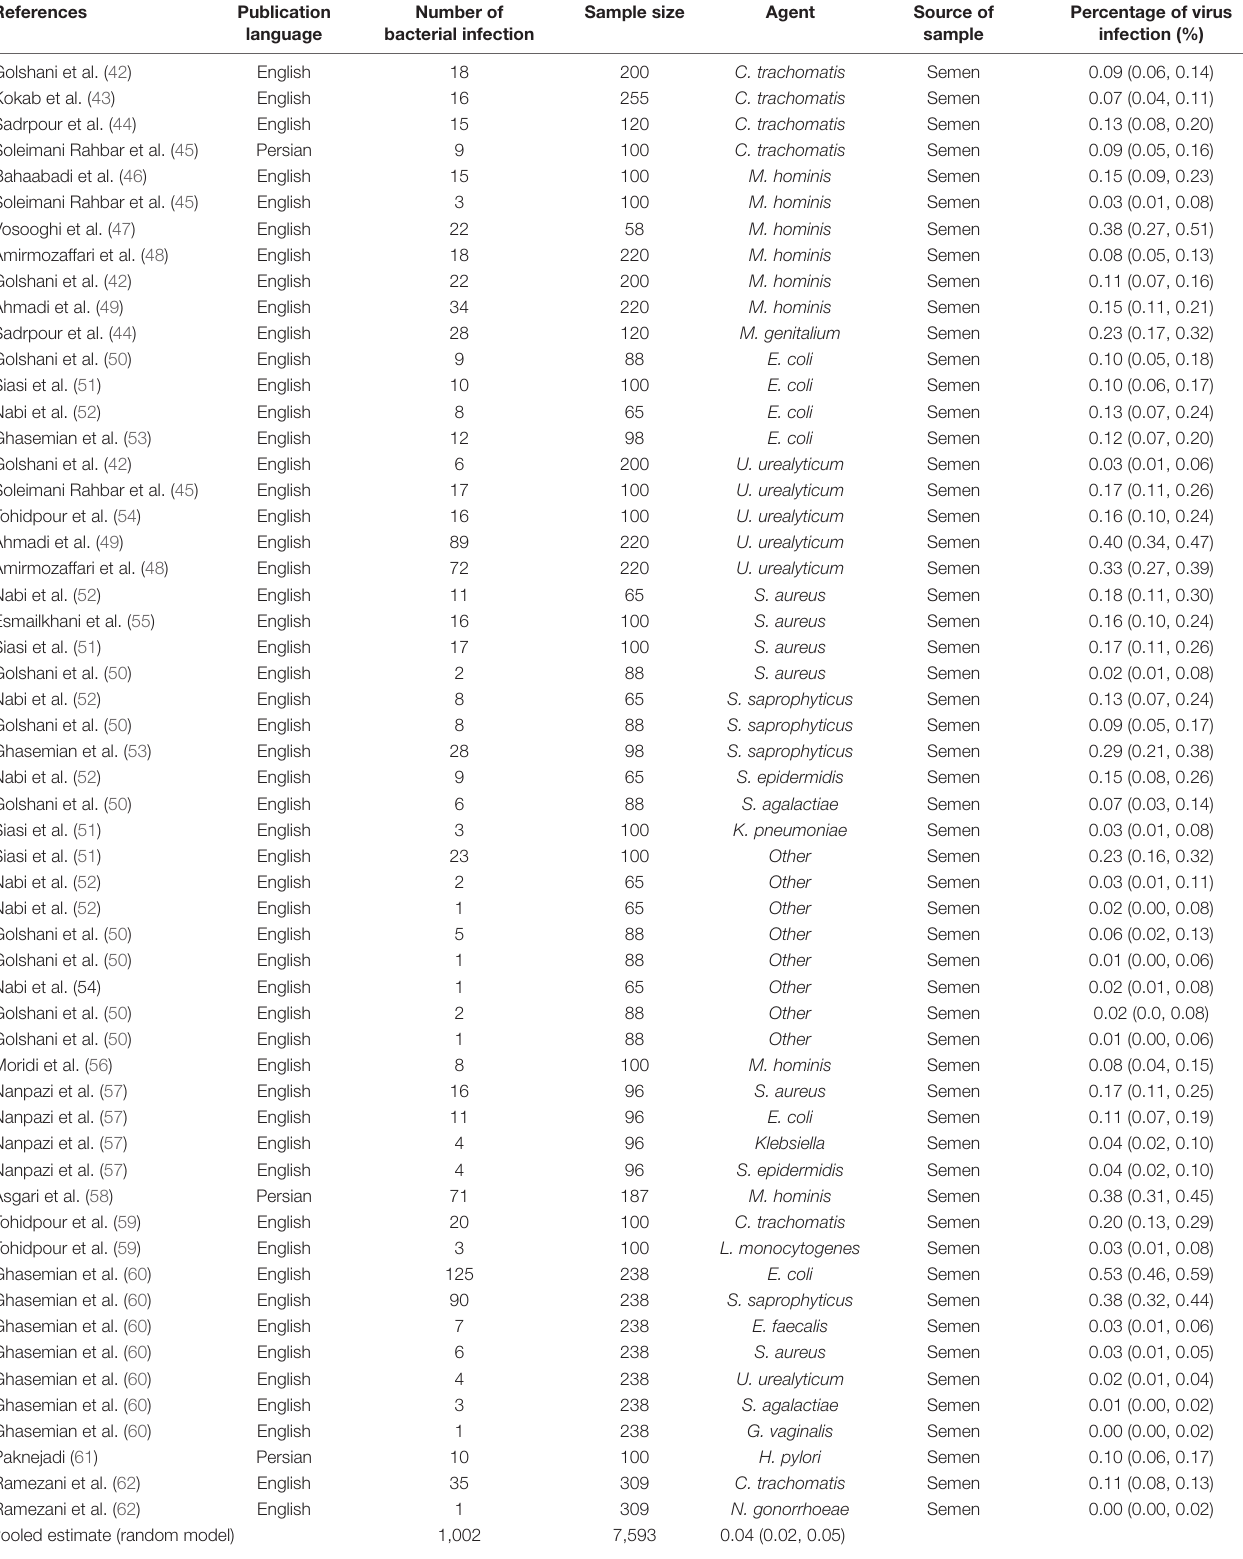
TABLE 4 | Cross-sectional studies on bacteria included in the